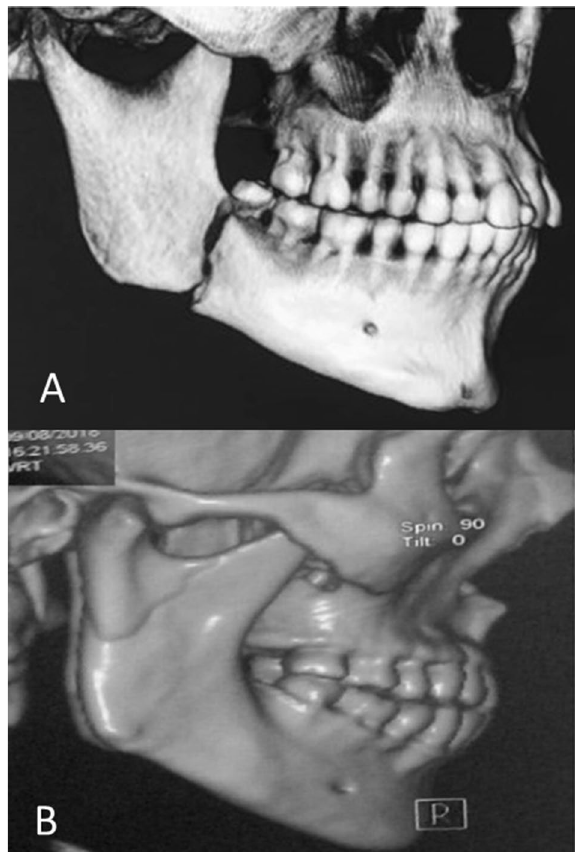
Figure 1. ( A ) Mandibular angle fracture; ( B ); Condylar